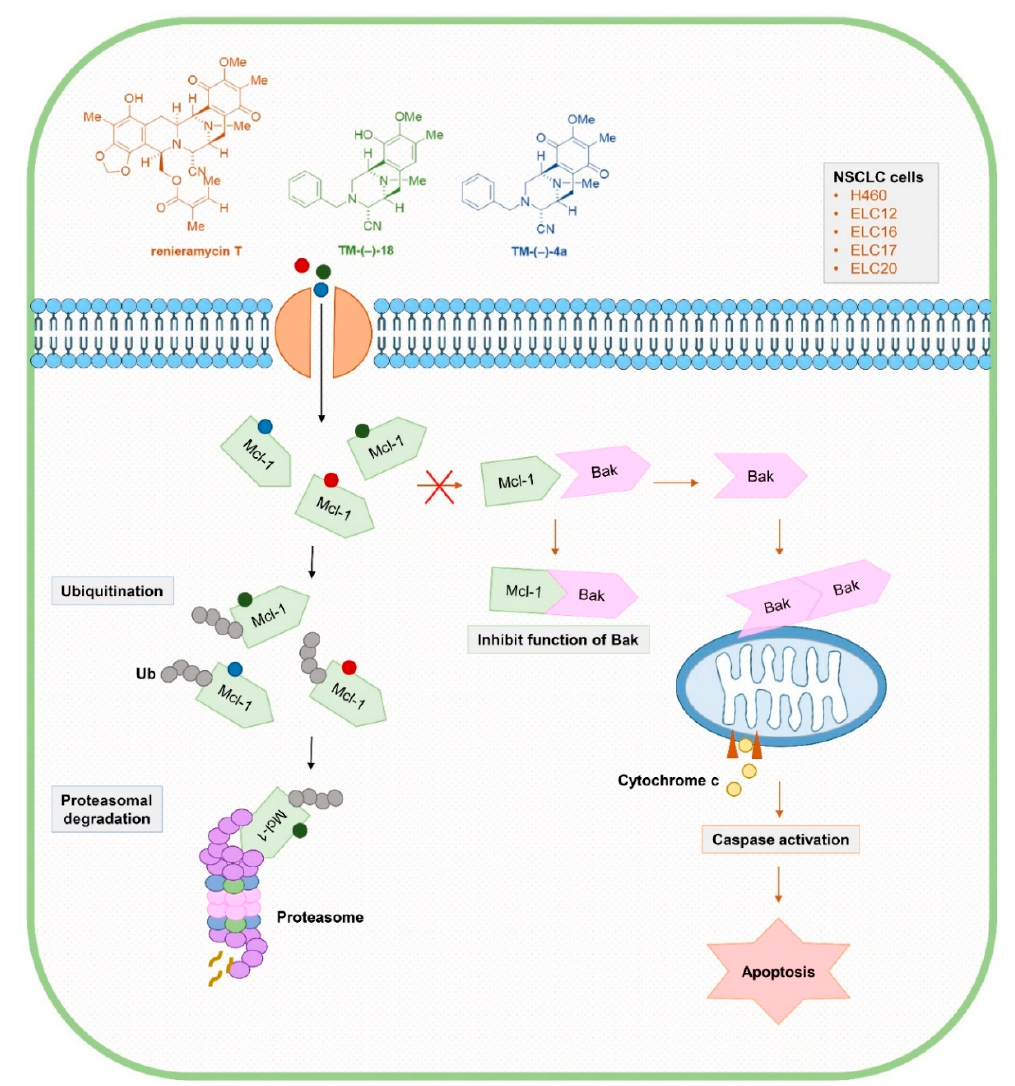
Figure 7. Renieramycin T (RT) and the simplified right-half model of RT compounds: TM-(–)-18 and TM-(–)-4a could enhance the absence of the Mcl-1 protein levels through Mcl-1 proteasomal degradation, resulting in the apoptosis of NSCLC cells. Mcl-1 normally functions as an anti-apoptotic protein by forming a complex with Bak. However, when Mcl-1 disappears, Bak is relieved to form an oligomerization that can permeabilize the outer membrane of mitochondria. Cytochrome c is released to initiate the apoptosis mechanism through caspase activation.